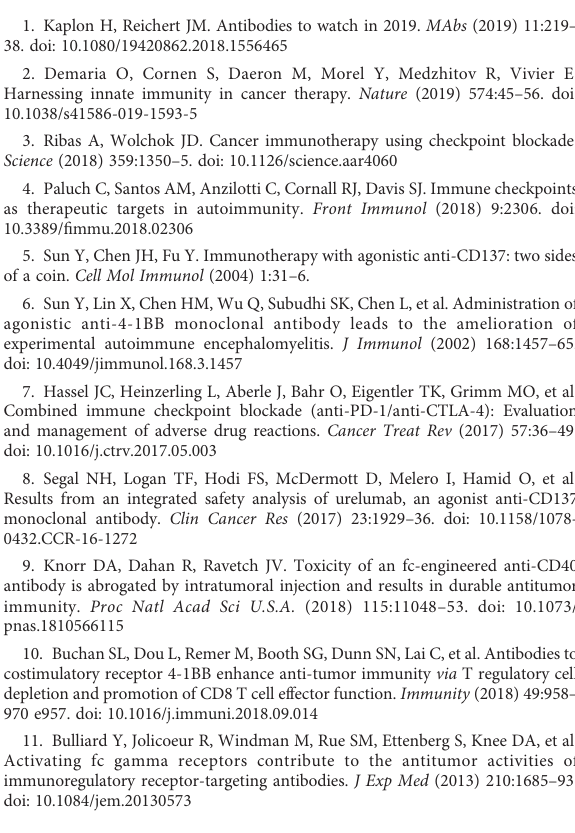
SUPPLEMENTARY FIGURE 3 Effect of urelumab deglycosylation on binding to human Fc g RI. (A) Shown is a Coomassie stained PAA gel (left panel) and a western blot analysis (right panel) using lens culinaris agglutinin (LCA) to detect the effect of deglycosylation on urelumab size or the urelumab core sugar structure, respectively. (B) Depicted is the binding of untreated urelumab ( a CD137)